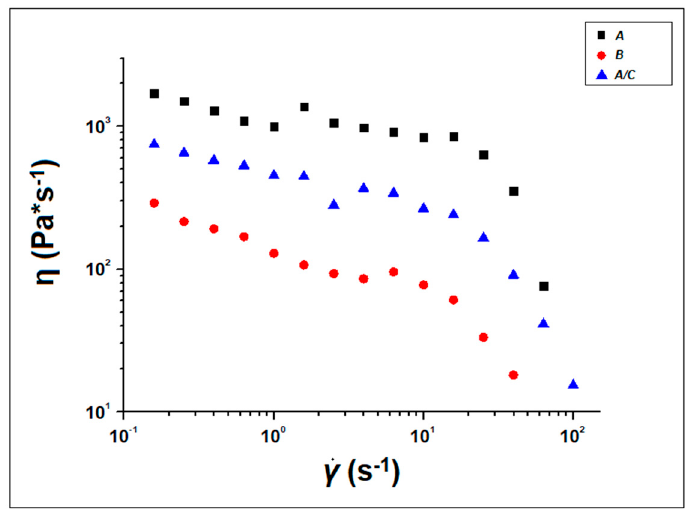
Figure 5. Rheological curves of A, B, and A/C blend.